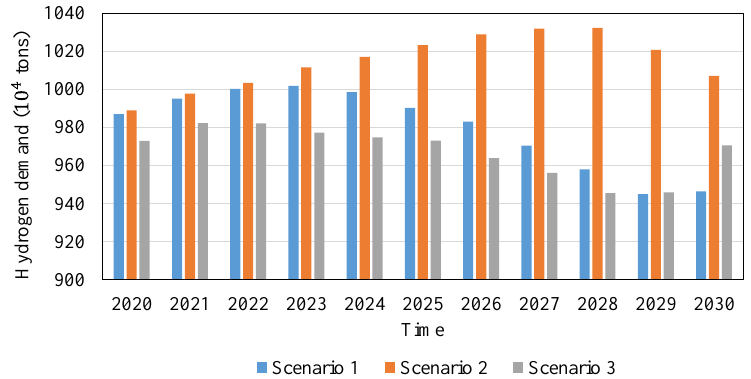
Figure 16. Hydrogen demand simulated until the year